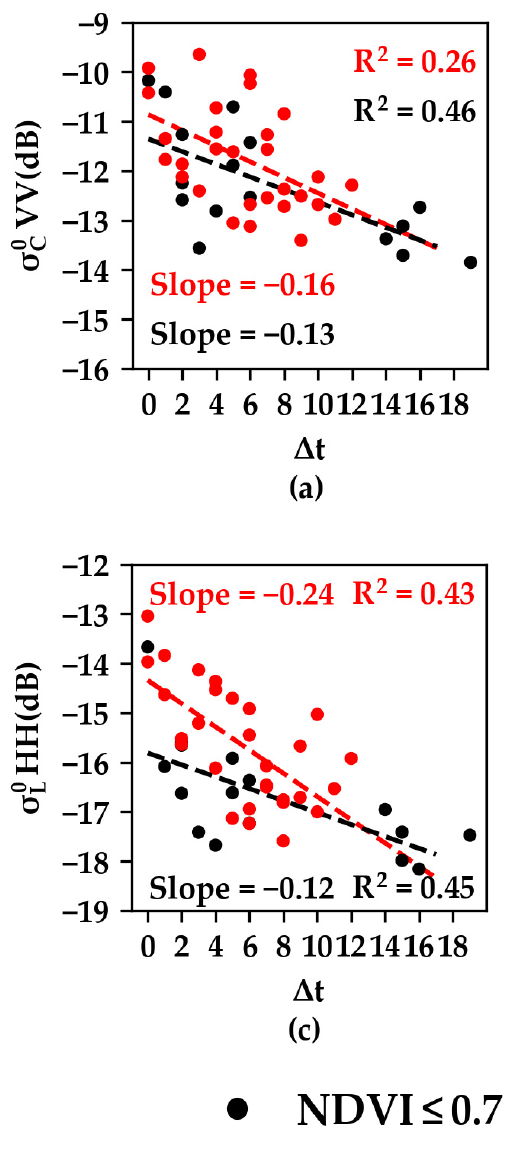
Figure 10. Variation in the σ (cid:2887)(cid:2868) and σ (cid:2896)(cid:2868) values as a function of the time difference ( ∆t in days) between the SAR acquisition date and the irrigation date for the C-band and L-and images acquired on 16/07/2019 in the growth cycle II. Each point represents a reference grassland plot. Black and red points correspond to plots with NDVI ≤ 0.7 and NDVI > 0.7 , respectively. ( a ) σ (cid:2887)(cid:2868) in VV, ( b ) σ (cid:2887)(cid:2868) in VH, ( c ) σ (cid:2896)(cid:2868) in HH, and ( d ) σ (cid:2896)(cid:2868) in HV.